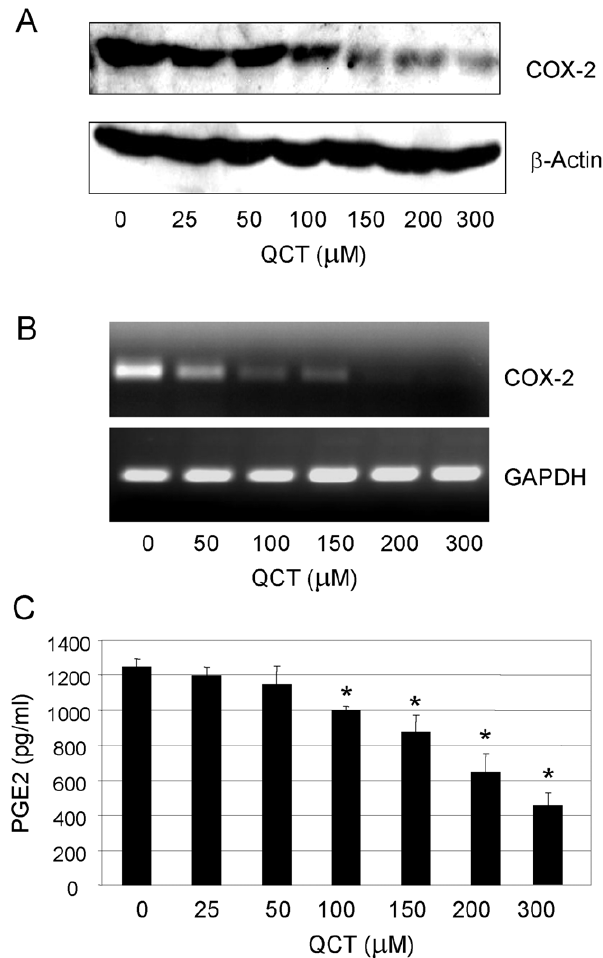
Figure 1. Quercetin suppressed COX-2 expression and PGE2 production. Human MDA-MB-231 cells were treated with quercetin for 48 h. The COX-2 proteins ( A ) and mRNA ( B ) were analyzed by Western blotting and RT-PCR, respectively, and PGE2 in medium of MDA-MB-231 cells was tested by ELISA ( C ). b -Actin and GAPDH were used as controls for sample loading. This is a representative of three blots. Each bar denotes mean 6 SD of three experiments. *, P , 0.05, significant differences between treatment groups and control